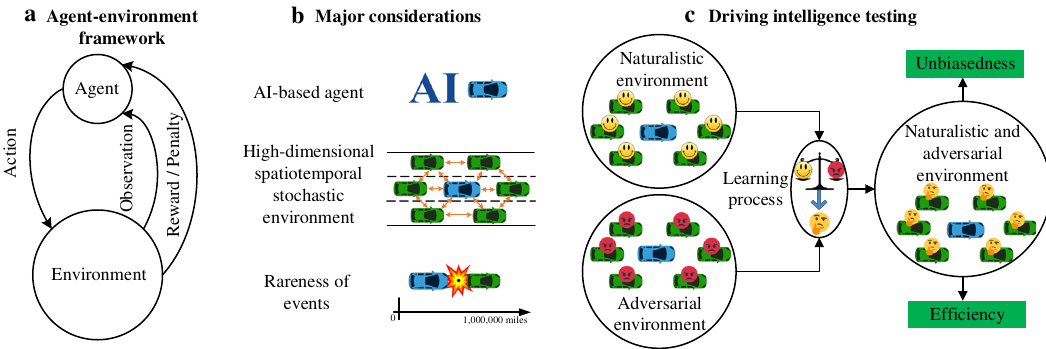
Fig. 1 Driving intelligence testing with NADE. a Agent-environment framework. b Major challenges for agent-environment framework include the dif fi culty for applying traditional software validation methods for testing arti fi cial intelligence (AI) based agents, the “ curse of dimensionality ” for modeling complex dynamic driving environment, and rareness of events of interest for driving intelligence testing. The blue vehicle denotes the autonomous vehicle, and the green vehicles denote background vehicles. c The NADE learns to balance the naturalistic environment and adversarial environment for driving intelligence testing of AVs based on the agent-environment framework, while ensuring unbiasedness and improving ef fi ciency. The images of vehicles, balance scale, and explosion are previously published under the Creative Common CC0 1.0 Universal Public Domain Dedication. The image of smiley face is previously published under the Creative Commons Attribution-Share Alike 3.0 Unported license. The images of angry face and thinking face